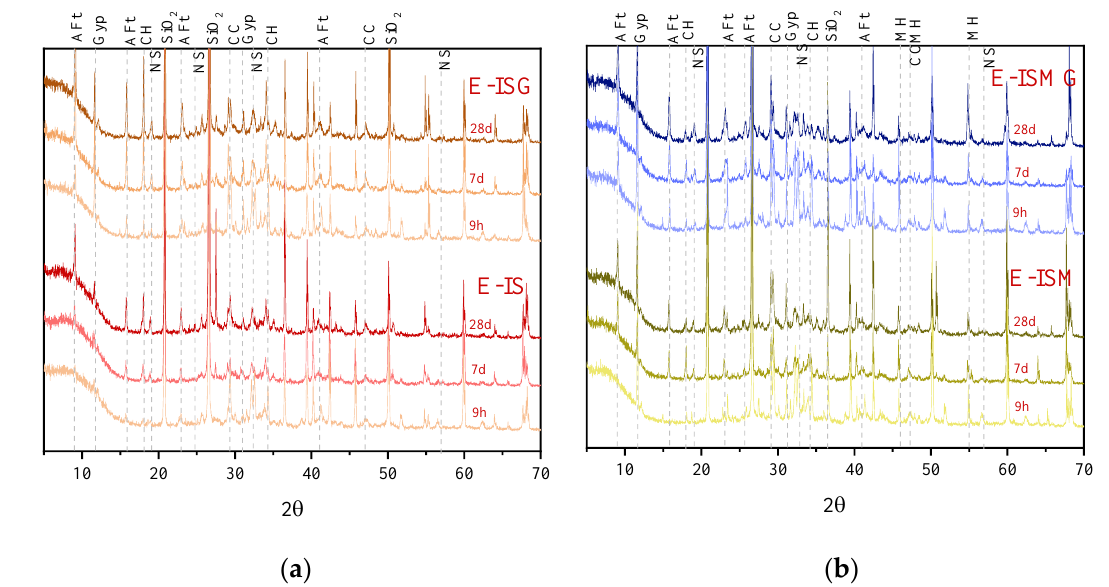
Figure 9. XRD results of specimens immersed in 7% sulfate solution at 9 h, 7 days and 28 days, respectively ( a ) E-IS and E-ISG, ( b ) E-ISM and E-ISMG (Aft: Ettringite Gyp: Gypsum CH: Portlandite NS: Sodium sulfate hydrate CC: CaCO 3 MH: Magnesium hydrate).